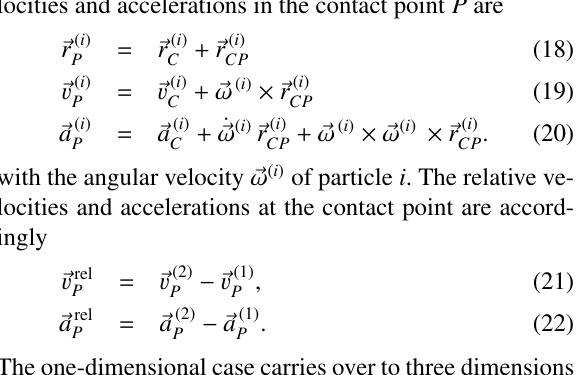
Figure 3. Height of a block on a slope with friction coe  cients below, at and above the critical friction in the main window and e ↵ ect of the time step on the creep in the insert.